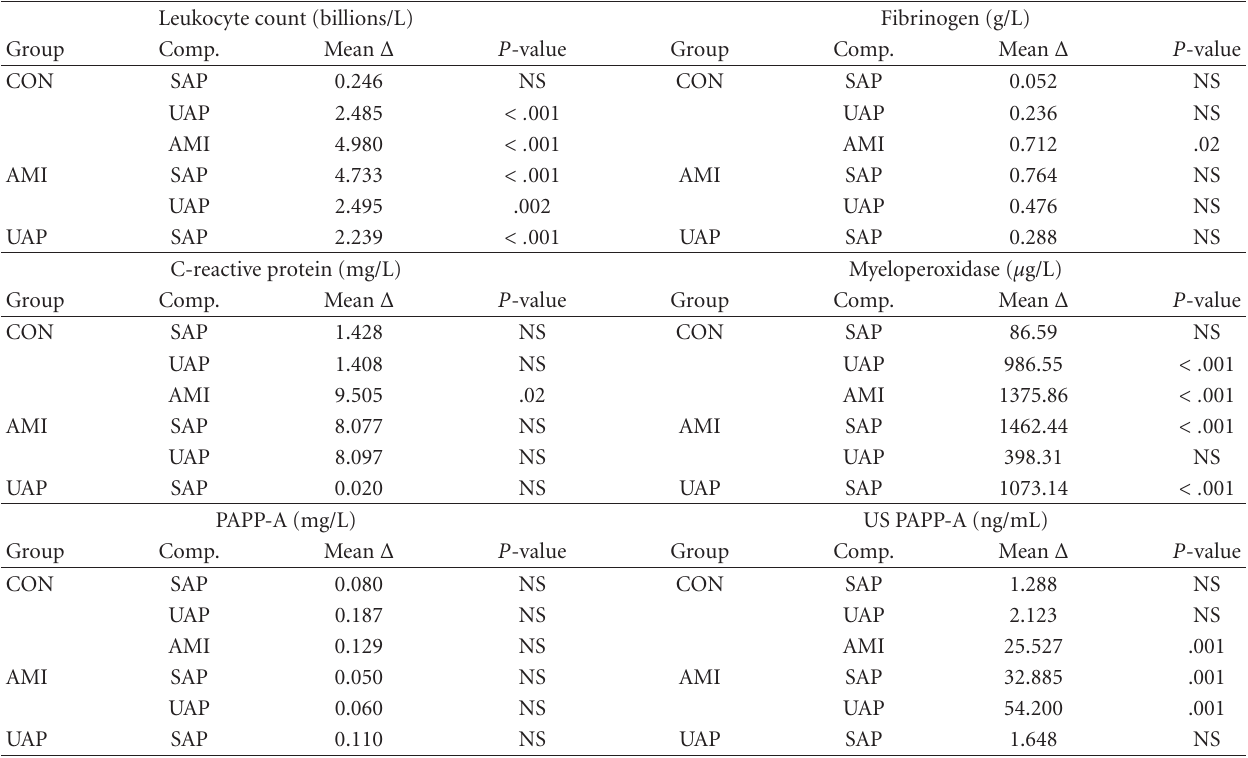
Table 2: Pairwise comparisons of serum biomarker level di ff erences. Leukocyte count (billions/L)